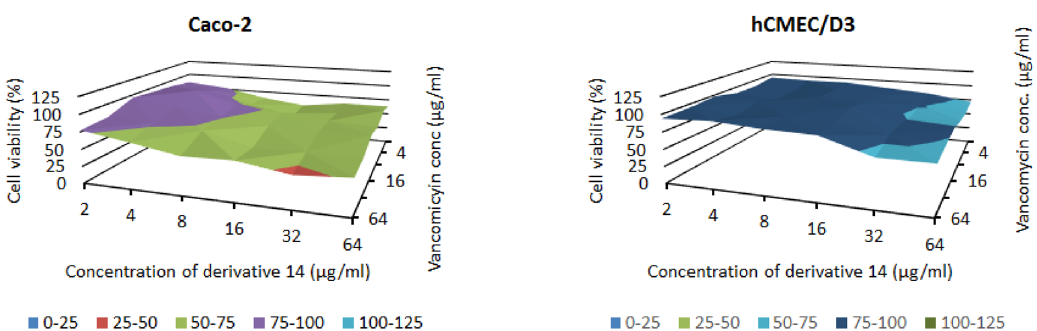
Figure 11. Cytotoxic effect of vancomycin in combination with compound 14 towards Caco-2 and hCMEC/D3 cells, measured by checkerboard